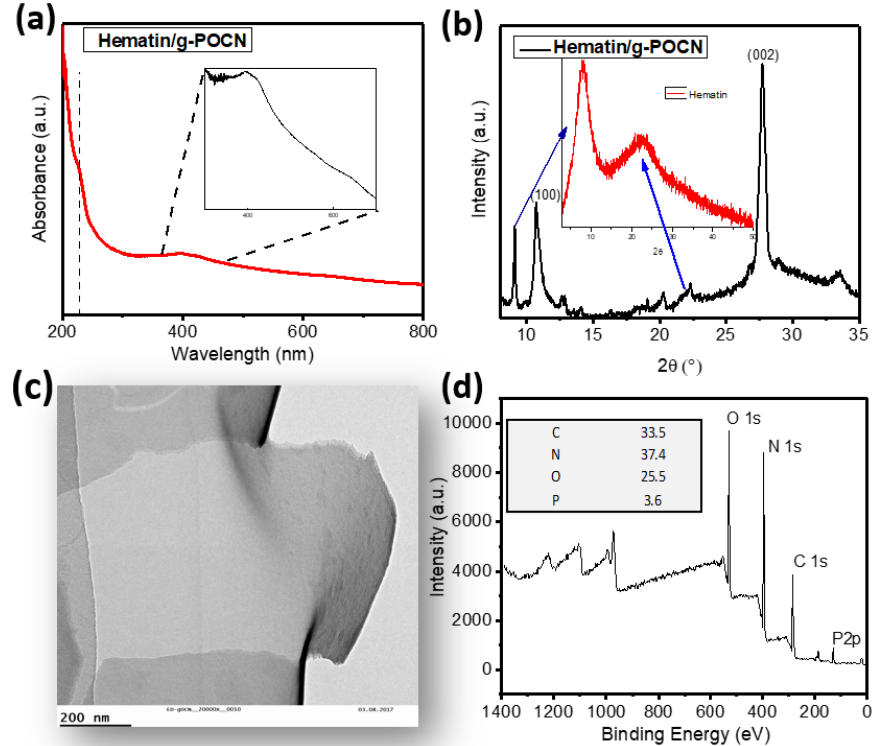
Figure 2. ( a ) UV-Vis spectrum of Hematin Supported in g-POCN, inset: magnification of the 400 – 700 nm region of the hematin contribution. ( b ) Hematin/g-POCN diffractogram, inset: Hematin diffractogram, diffraction maxima related to hematin. ( c ) g-POCN Transmission electronic micro- graph, the detail shows a sheet fragment on an edge. ( d ) g-POCN XPS spectra, inset: percentual surface elemental concentration.